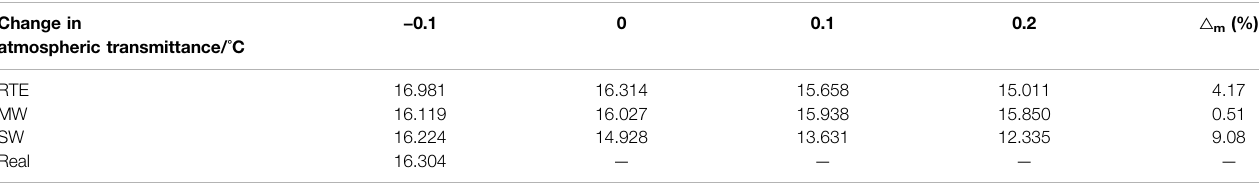
TABLE 5 | Variation in surface temperature due to atmospheric transmittance errors (unit: ° C).